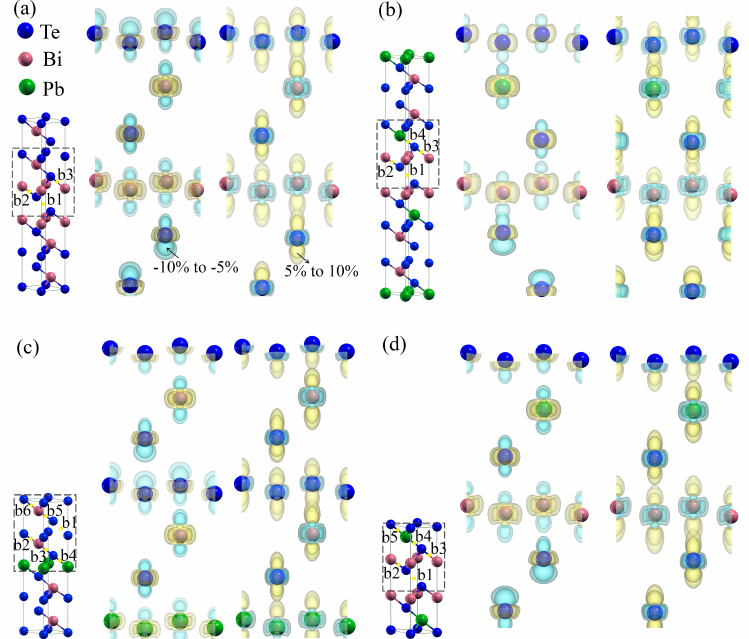
Figure 9. Charge density differences in Bi 2 Te 3 ( a ), PbBi 2 Te 4 ( b ), PbBi 4 Te 7 ( c ) and Pb 2 Bi 2 Te 5 ( d ) under compressive strains ( − 10% and − 5%) and tensile strains (5% and 10%). The isosurface is set to 0.05 e/bohr 3 for both accumulation (yellow) and depletion (cyan). The arrows indicate the evolution of the charge density difference as the strain evolves. b1–b6: Bond critical points.